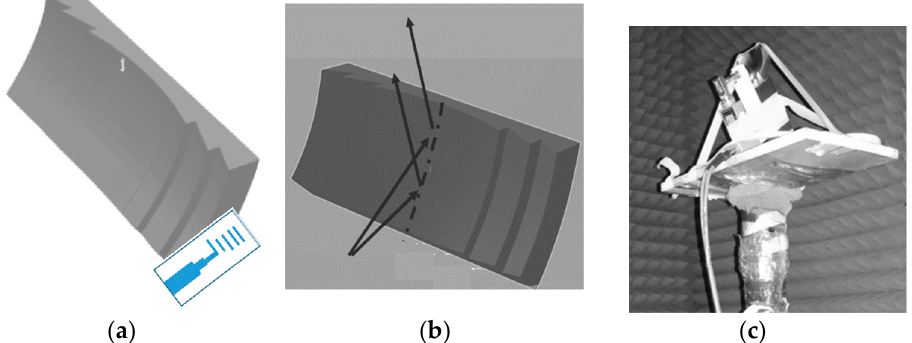
Figure 12. ( a ) Three-dimensional structure of the segmented parabolic surface ( b ) Rays on segmented parabolic surface ( c ) The segmented parabolic surface in the microwave anechoic chamber.